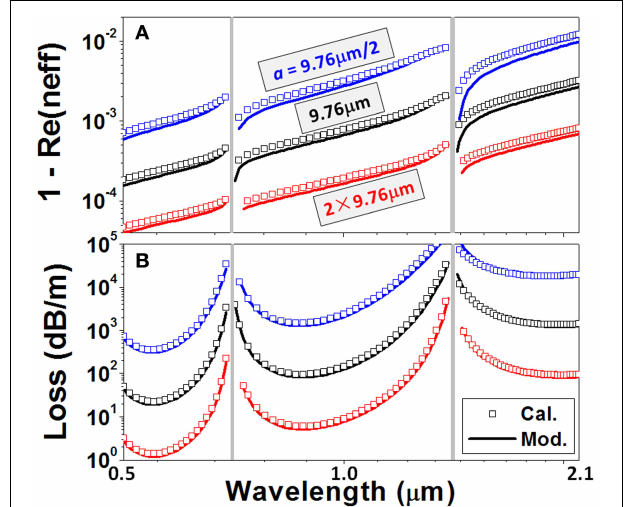
FIGURE 3 | (A) Propagation constants (the real parts of the effective indices) and (B) attenuations of three circular ring ARFs as a function of the wavelength. The precisely calculated results (the hollow squares) are from a transfer matrix approach [34], and the modeled results (the solid lines) are from Equation (9). t 0.67 µ =